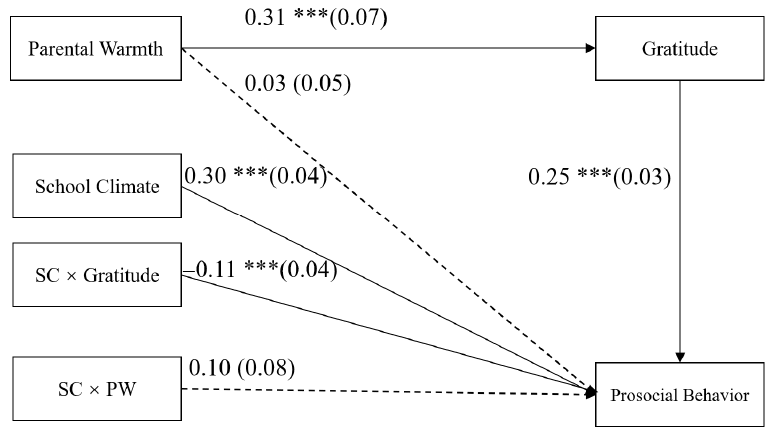
Figure 3. Model of the moderating role of school climate on the indirect relationship between parental warmth and prosocial behavior. SC, school climate; PW, parental warmth. Values are unstandardized coefficients and the standard error. Paths between gender and age in the model are not displayed because none of these paths were significant. *** p < 0.001.